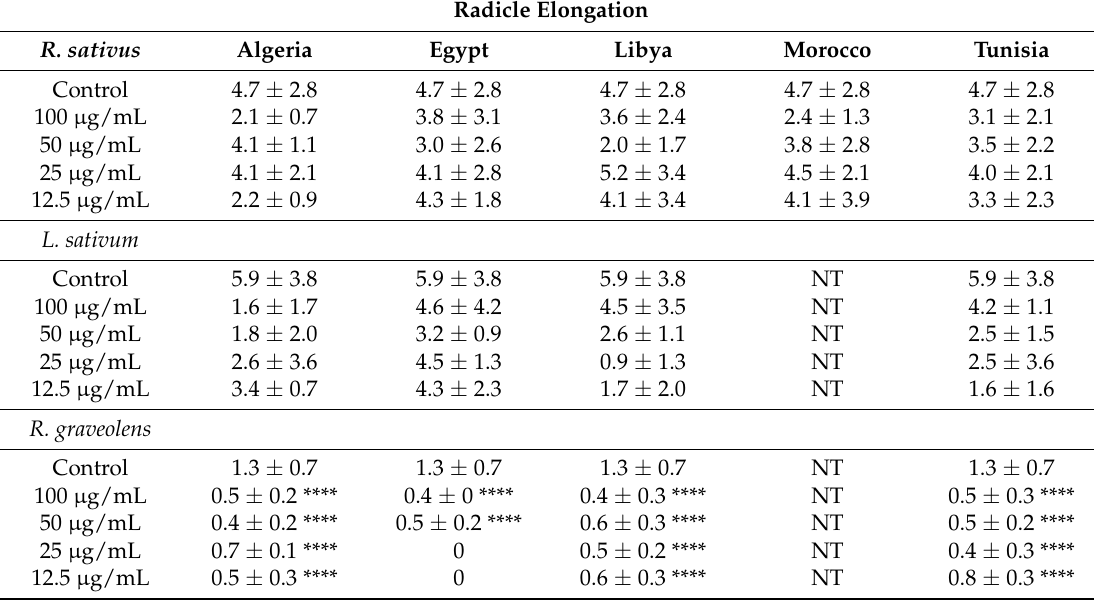
Table 4. Phytotoxic activity of the essential oil P. harmala from Algeria, Egypt, Libya, Morocco and are expressed in cm. Results are expressed as the mean of three experiments ± standard